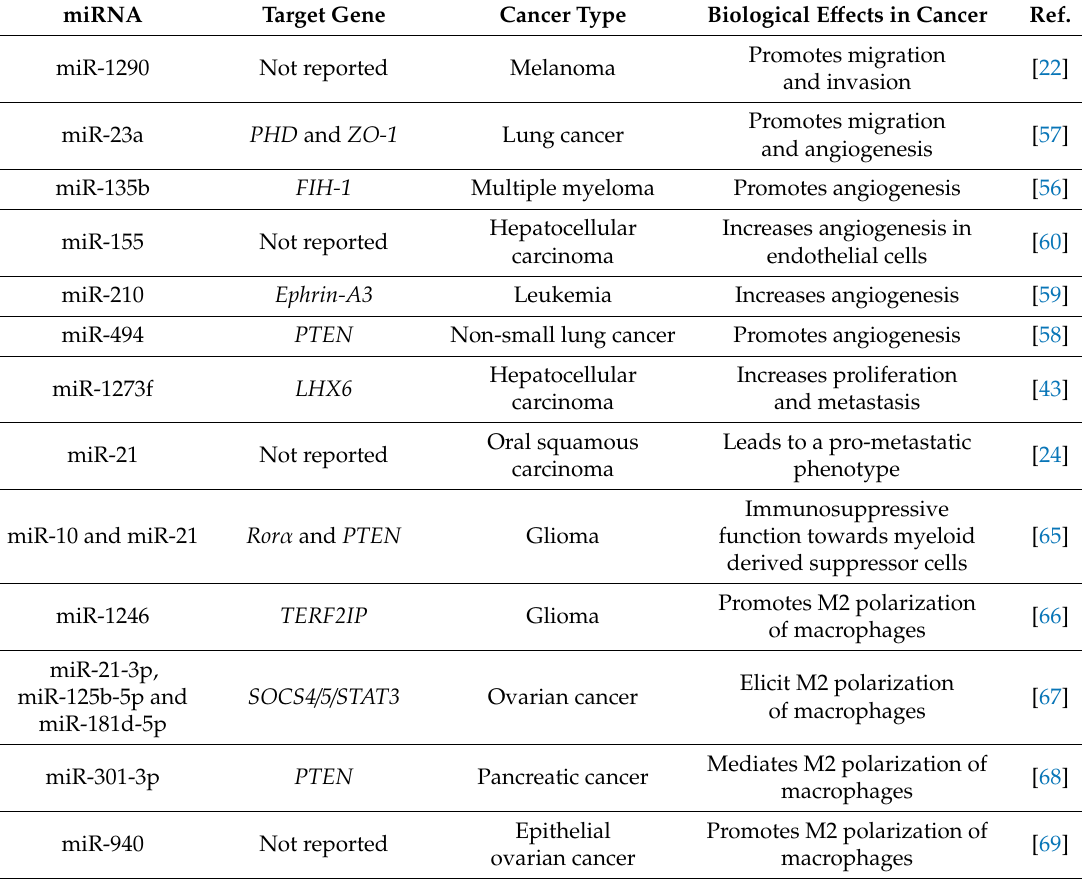
Table2. miRNAsandlncRNAsenrichedinsmallextracellularvesiclesderivedfromhypoxiccancercells. miRNA Target Gene Cancer Type Biological E ff ects in Cancer